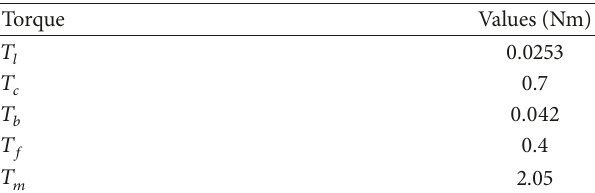
Table 1: Summary of torque budget of the tilting calibration mechanism.